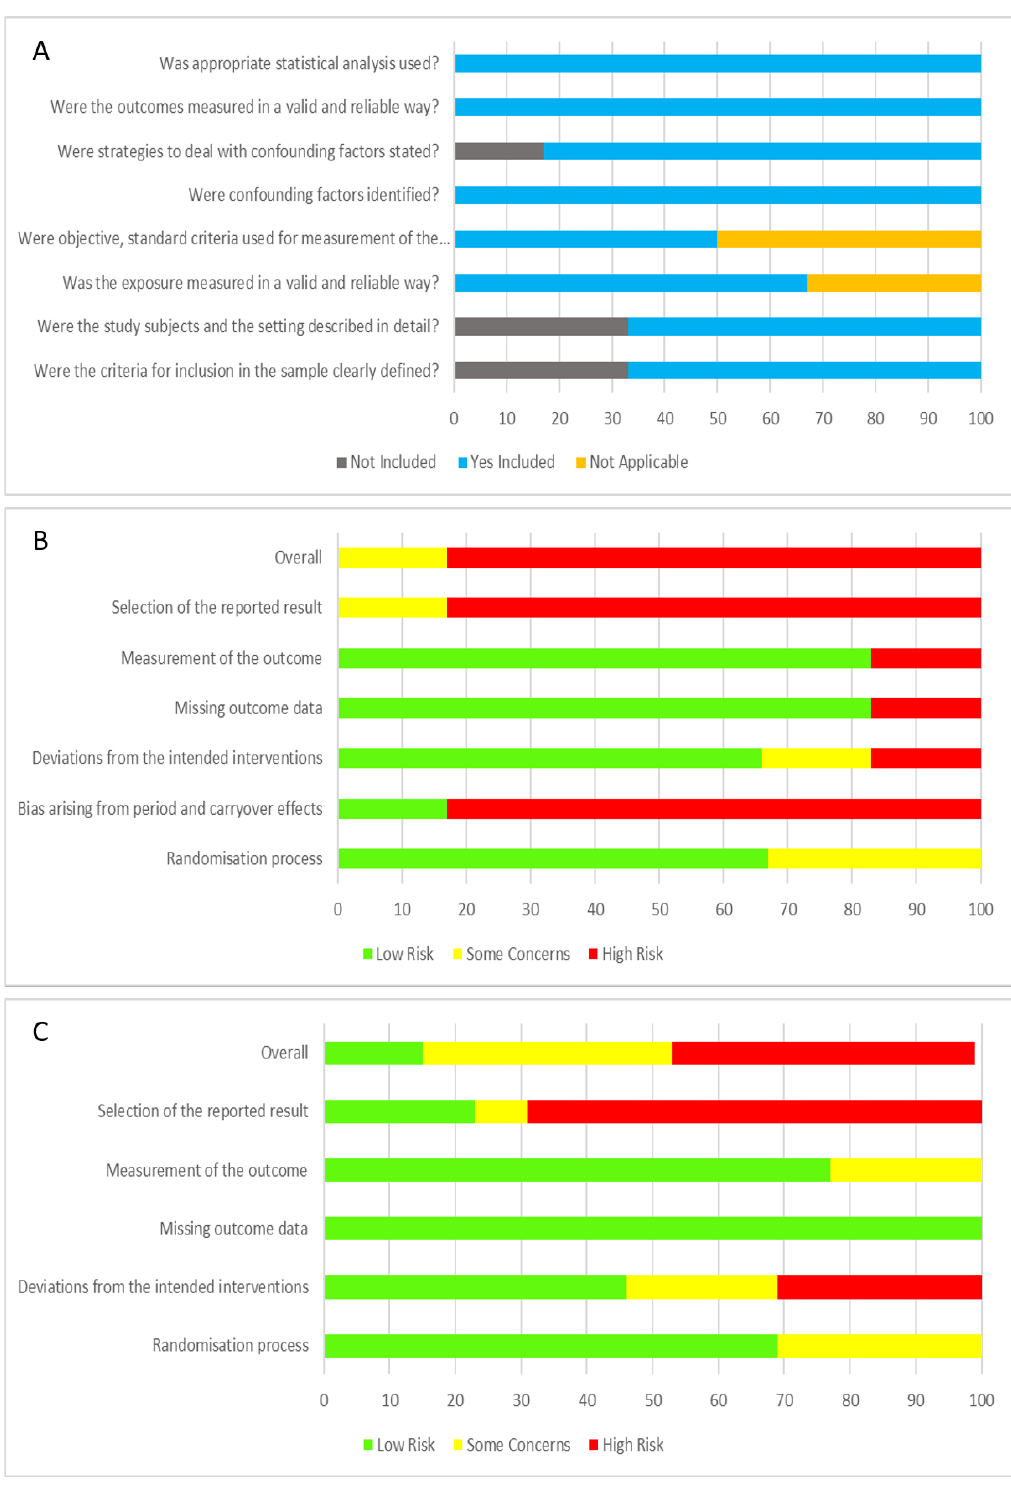
Figure 2. Summary of risk and bias analysis of all studies. ( A ) JBI critical appraisal for analytical cross-sectional studies ( n = 6); ( B ) Summary of RoB2 risk of bias for cross-over design intervention studies analysis ( n = 6); ( C ) Summary of Rob2 risk of bias for parallel design intervention studies analysis ( n =